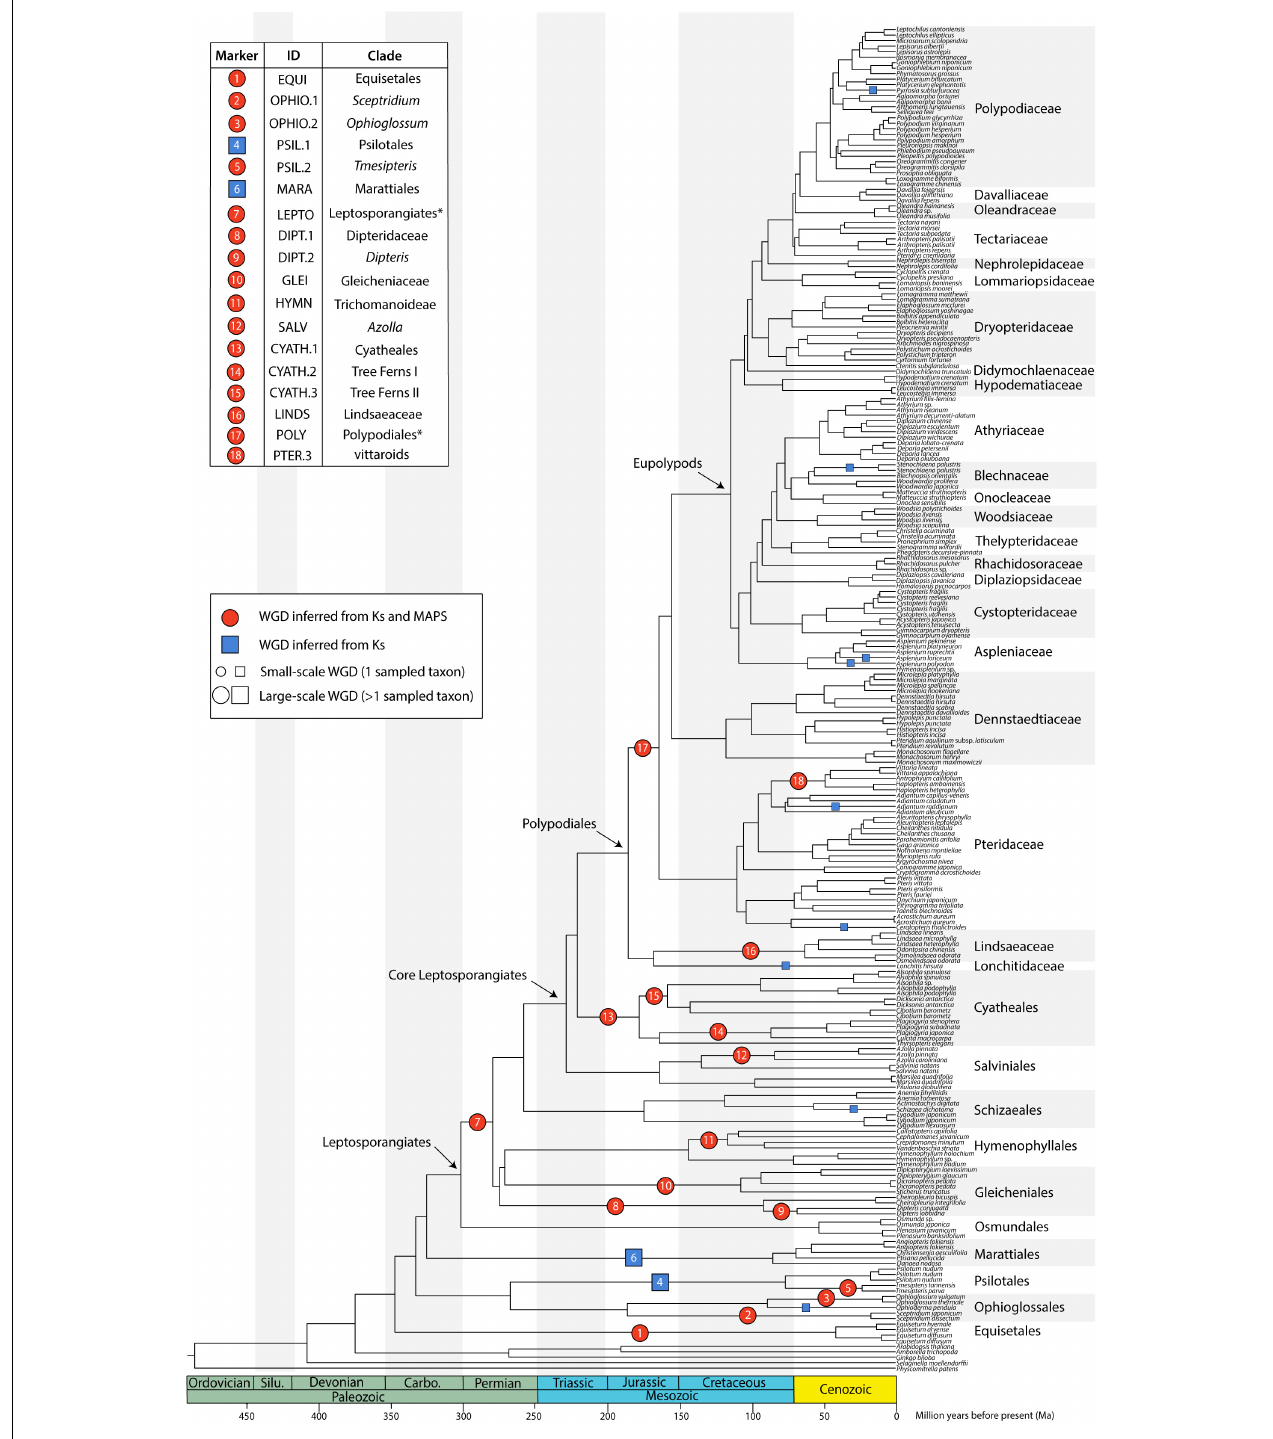
FIGURE 2 | Species tree generated from 2884 single copy nuclear loci (SCO60 dataset) under the multi-species coalescent. Divergence times are based on a penalized likelihood method in TreePL. Inferred whole genome duplications (WGDs) are placed on the tree (note that the age of the WGDs are not depicted, rather events are placed on the midpoint of the branches). Events inferred from K S and MAPS analyses are shown as red circles, and events inferred from K S evidence only are shown as blue squares. The size of the symbol reflects whether the event is large-scale (larger symbol, including more than one sampled taxon) or small-scale (smaller symbol, including only one sampled taxon). Asterisks for LEPTO and POLY events indicate there are no current names for the clades corresponding to the taxa affected by these events: LEPTO is shared by leptosporangiate ferns excluding Osmundales and POLY is shared by Polypodiales excluding Lindsaeineae and